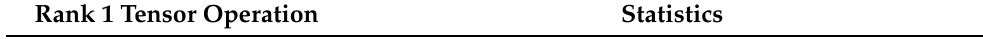
Table 8. Raspberry Pi III B+ benchmark statistics for rank 1 tensor operations with k = 32 (times in